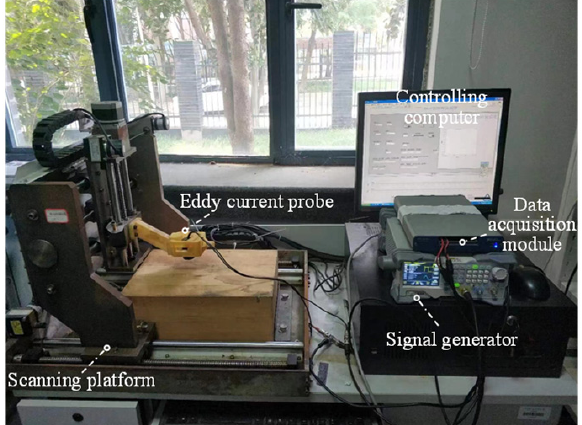
Figure 5. Experimental platform for defect detection of lead sealing.